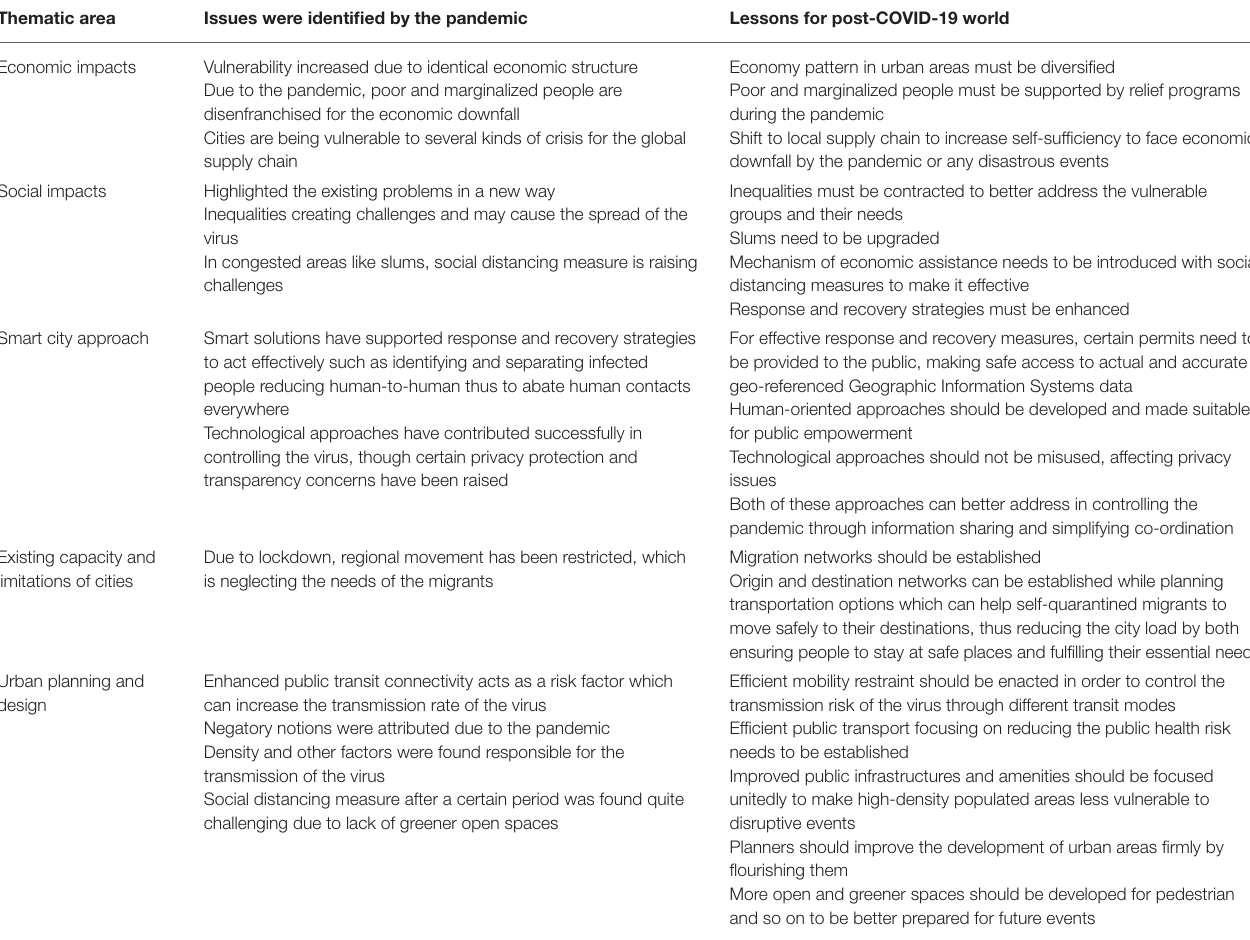
TABLE 1 | Major areas focused by pandemic and lessons learned for pandemic-resilient urban planning and design for post-COVID-19 world (modified after Sharifi, 2020). Thematic